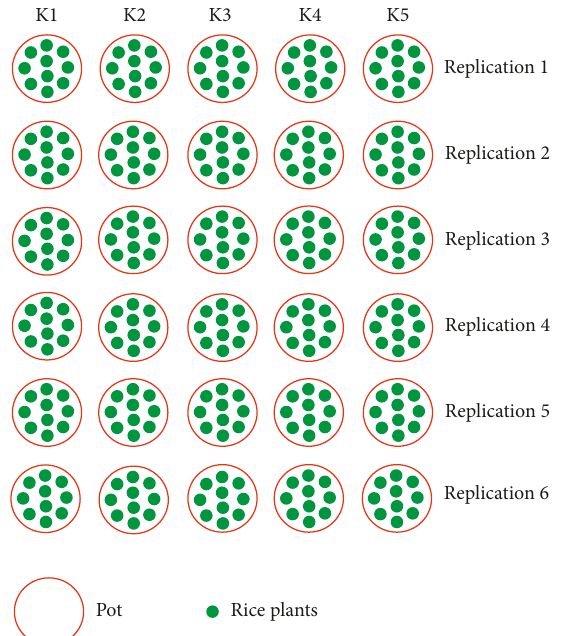
Figure 2: Plants were grown in the greenhouse under natural light with constant environment conditions of day/night (30 ° C/25 ° C) and humidity of 50%.